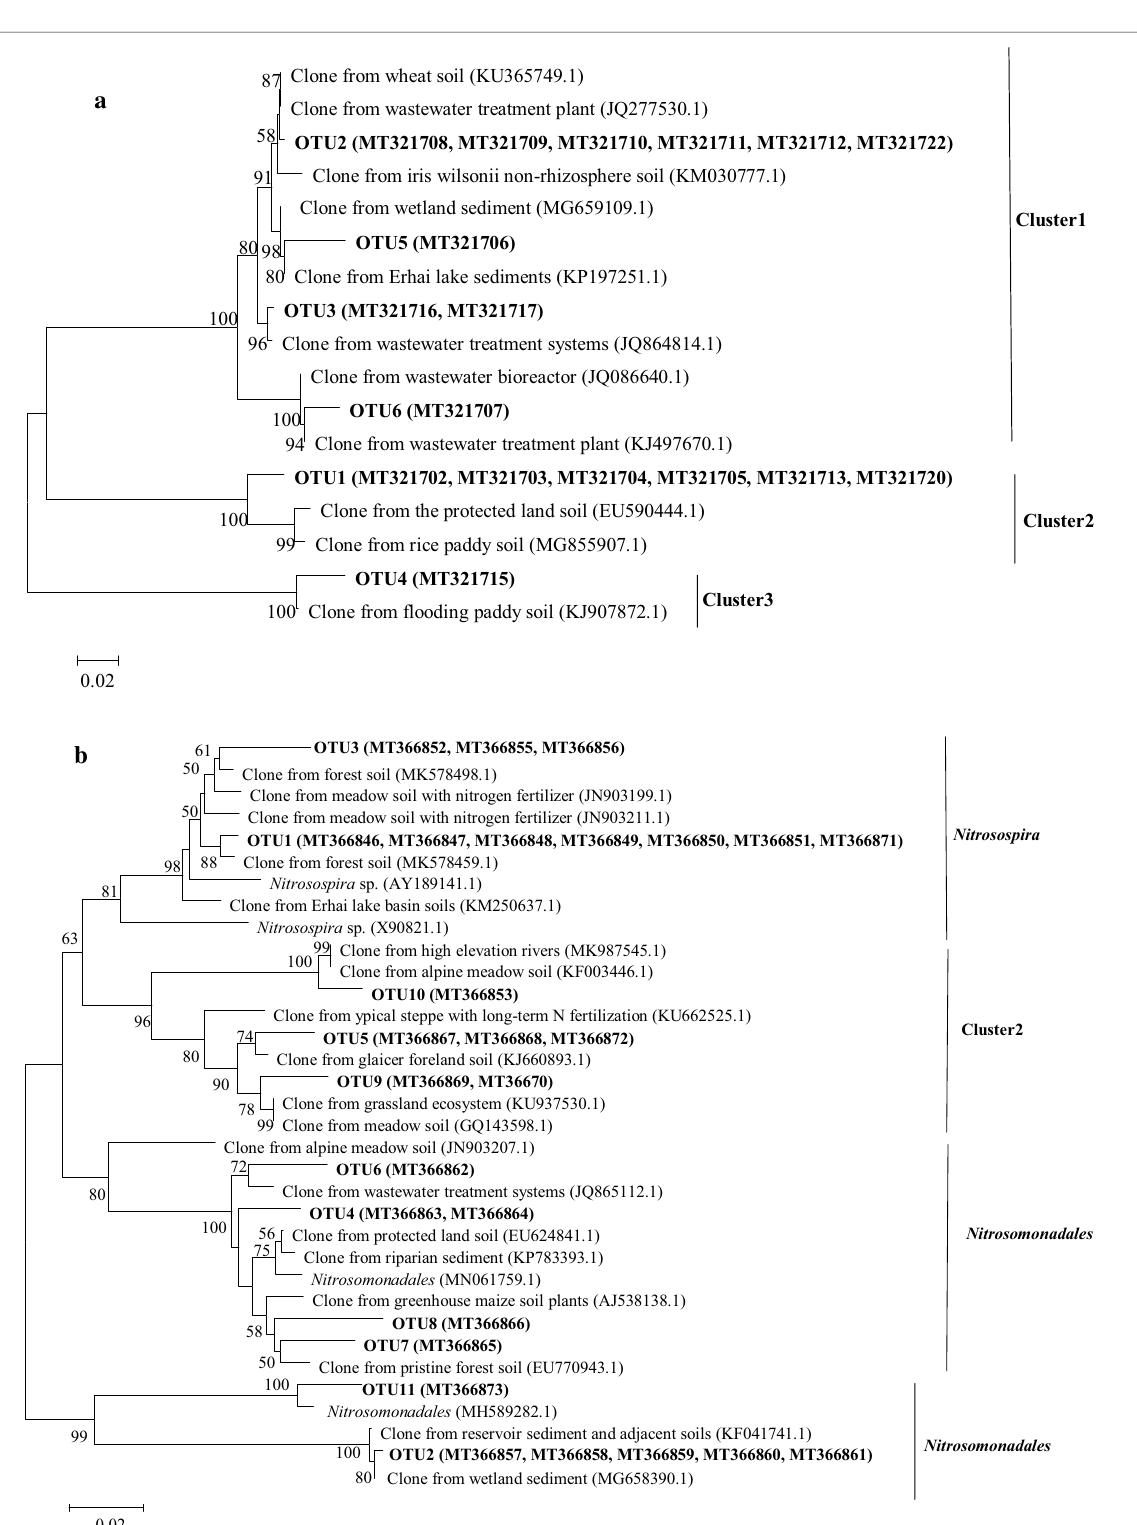
Fig. 6 Neighbor-joining trees based on partial archaeal amoA genes ( a ) and bacterial amoA genes ( b ). Names of sequences obtained in this study are marked in bold, the numbers in parenthesizes are their respective T-RF sizes belonging to the OTU. Bootstrap analysis of 1000 replicates values are shown next to each